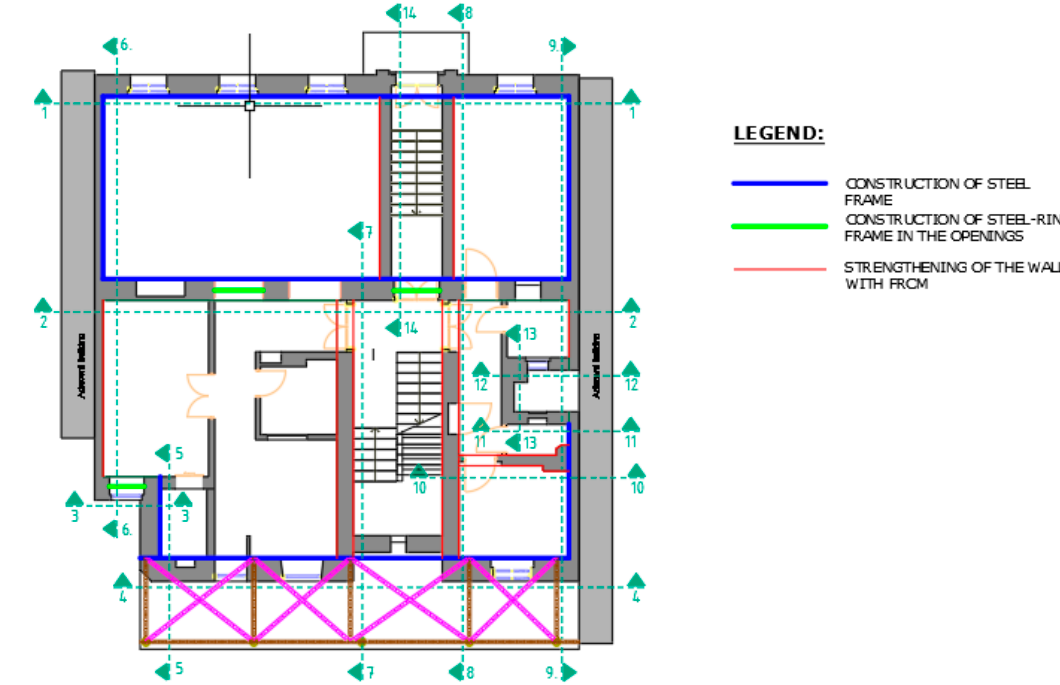
Figure 19. Strengthening measures of the walls at the ground floor level.